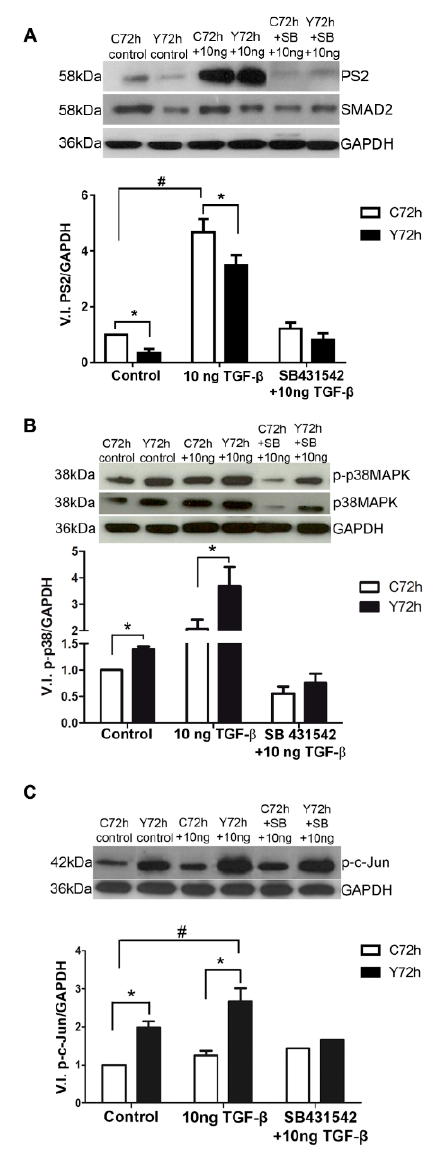
Figure 6. PS2, phospho-p38 MAPK, and phospho-c-Jun detection in normal and infected cardiac fibroblasts with T. cruzi . ( A ) PS2 detection. Normal CF showed an increase of SMAD2 phosphorylation when treated with 10 ng / mL of TGF- β . Infected CF were unable to trigger the classical signaling pathway, even when treated with 10 ng / mL, compared to the uninfected pair. The SB431542 inhibitor prevented SMAD2 phosphorylation in CF cultures after stimulation with TGF- β . ( B ) Phosphorylated p38 MAPK detection. In normal CF treated with 10 ng / mL of TGF- β , an increase of p38 MAPK phosphorylation detection was observed. T. cruzi infection did not result in significant di ff erences in p38 MAPK phosphorylation, although there was a tendency to increase in this signaling pathway. After addition of 10 ng / mL of TGF- β , the signaling pathway was triggered in CF. The inhibitor SB431542 prevented the p38 MAPK phosphorylation in both normal and infected CF treated with 10 ng / mL TGF- β . ( C ) Phosphorylated c-Jun detection. Note that infection by T. cruzi led to an increase in the c-Jun signaling pathway. The addition of TGF- β in normal cultures resulted in a 25% increase in c-Jun detection. The increase triggered by the infection remained and was enhanced by treatment with TGF- β . In all panels, white bars correspond to control, uninfected cultures (C72h), while black bars depict levels of T. cruzi (Y strain) infected cultures (Y72h). * p ≤ 0.05 compared their control pairs; # p ≤ 0.05 compared to untreated, uninfected controls N =